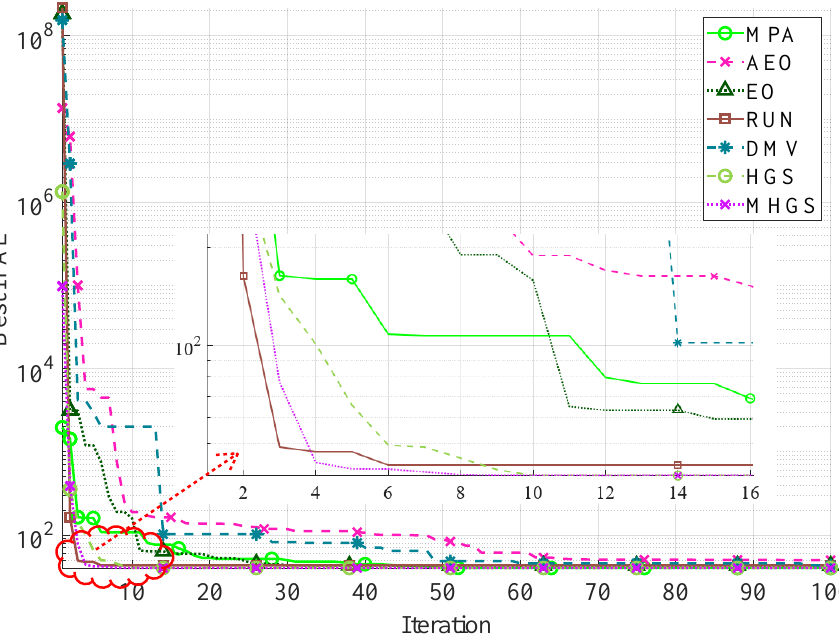
Figure 15. The convergence property of the proposed algorithm and others in the case of four interconnected areas with a load disturbance of